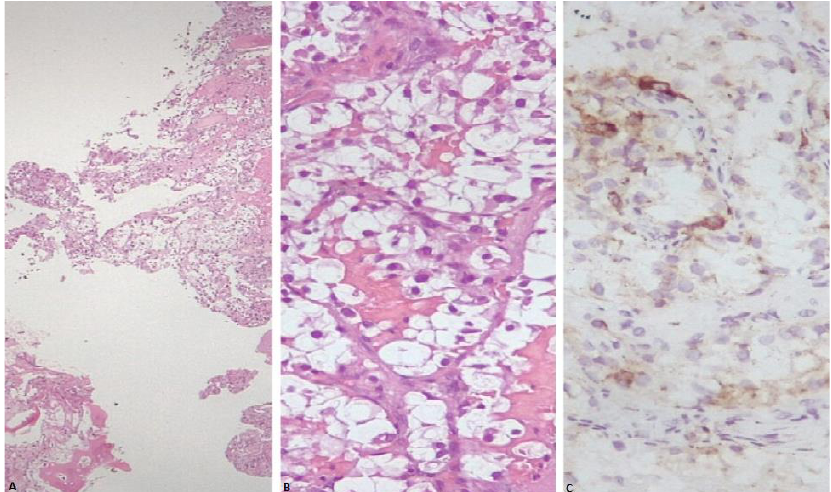
Figure 2. ( A ) Sheets of neoplastic cells showing abundant clear cytoplasm, infiltrating plates of trabecular bone (H&E stain). ( B ) Nests of neoplastic cells showing round to oval nuclei and abundant clear cell cytoplasm, partially surrounded by a thin and delicate vasculature (H&E stain). ( C ) Neoplastic cells within bone exhibiting focal granular cytoplasmic immunoreactivity for cathepsin K. FISH test for the detection of the TFE3 (Xp11.23) rearrangement was negative in both adrenal and bone lesions.